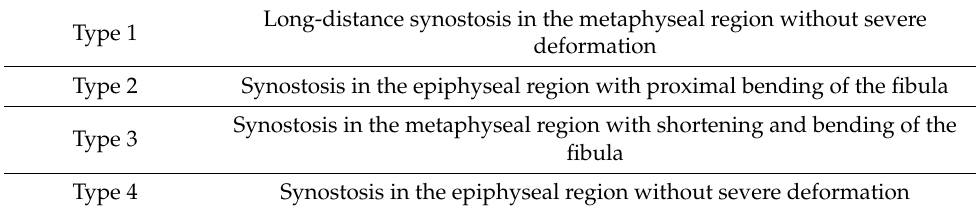
Table 1. Types of proximal tibiofibular synostosis according to O’Dwyer and